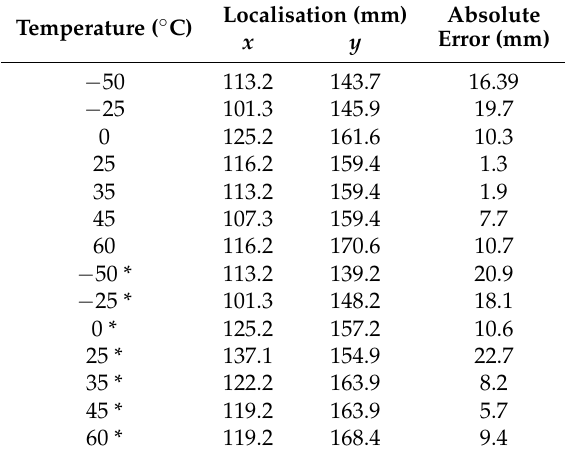
Table 3. BVID localisation error on SHM layer CFRP plate (50 kHz), actual location (115,160) mm. Baseline recorded at 25 ◦ C with the temperature-compensated current signal, using 5 or 4 transducers. * Indicates 4-transducer arrangement.